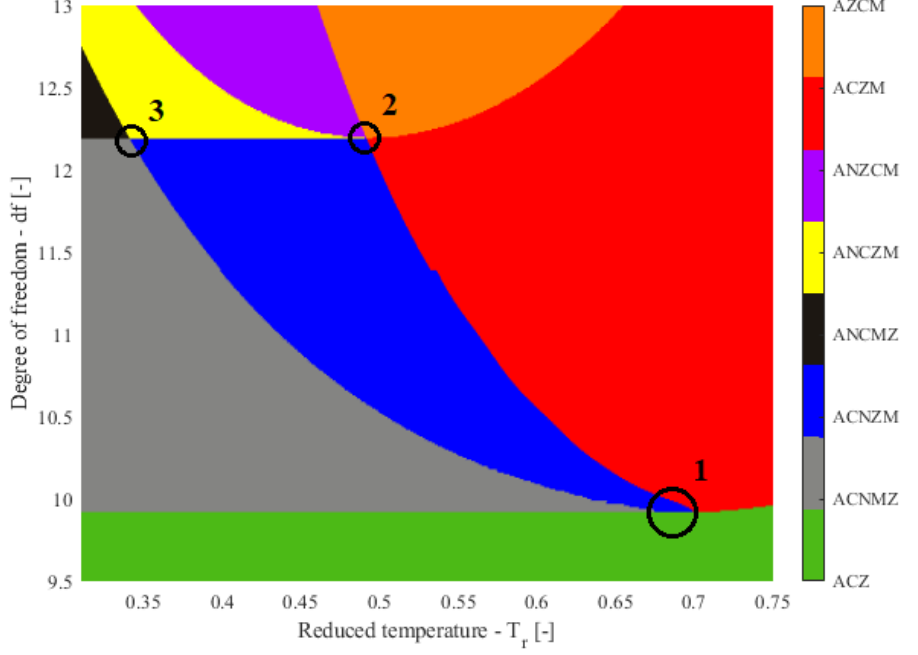
Figure 5. Magnified part of Figure 4 showing the multiple points of the map.